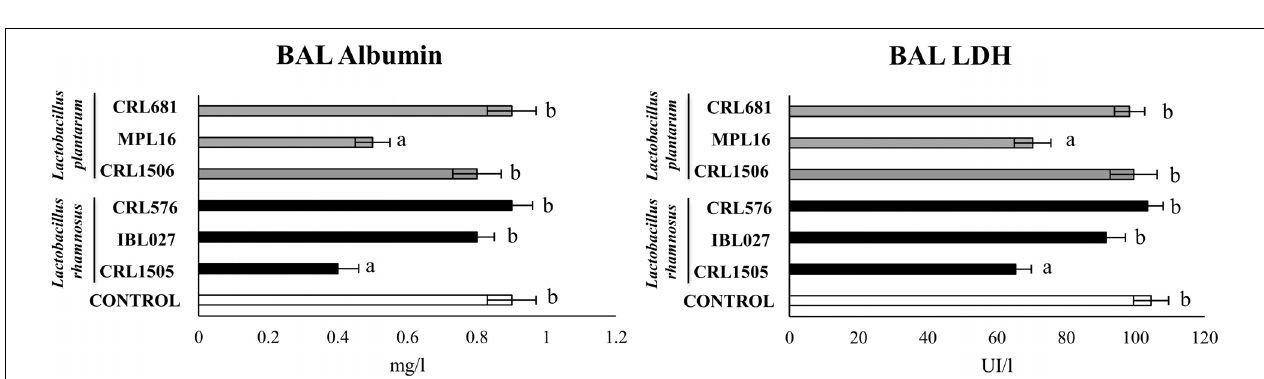
FIGURE 6 | Heat map analysis of the differentially regulated intestinal immune factors and serum injury markers before (basal) and after poly(I:C) challenge. Mice were orally treated with Lactobacillus rhamnosus CRL1505, L. rhamnosus IBL027, L. rhamnosus CRL576, Lactobacillus plantarum CRL1506, L. plantarum MPL16, or L. plantarum CRL681, and then challenged by the intraperitoneal route with the viral molecular–associated pattern poly(I:C).